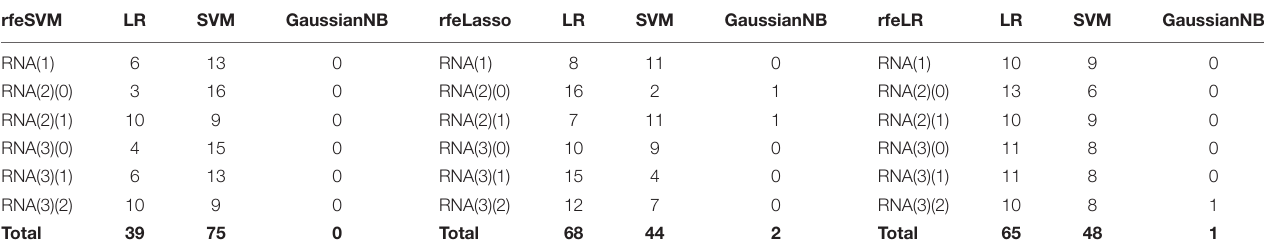
There were 19 feature subsets screened by rfeSVM/rfeLasso/rfeLR, with the numbers of features 10, 15, 20, ... , 100.